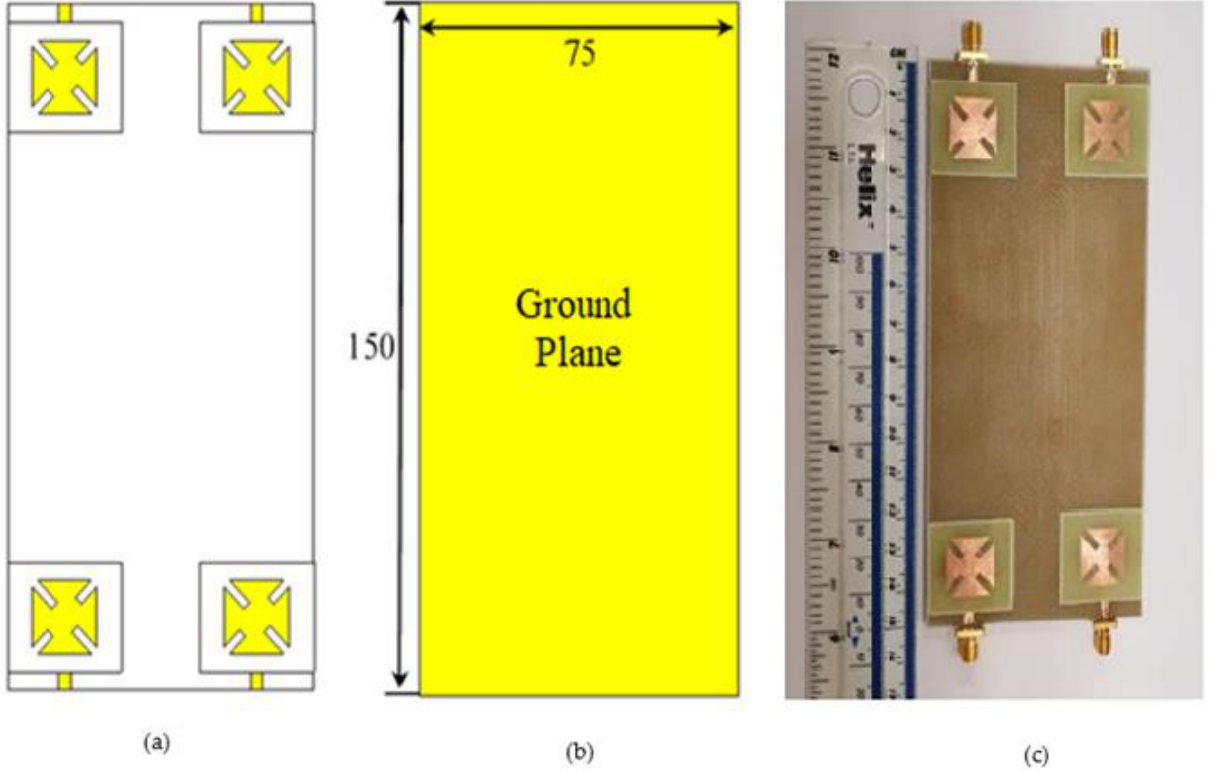
Figure 11. The proposed MIMO structure ( a ) top view of the antenna, ( b ) back view of the antenna, and ( c ) the prototype of the proposed MIMO antenna. (All dimensions are in mm).